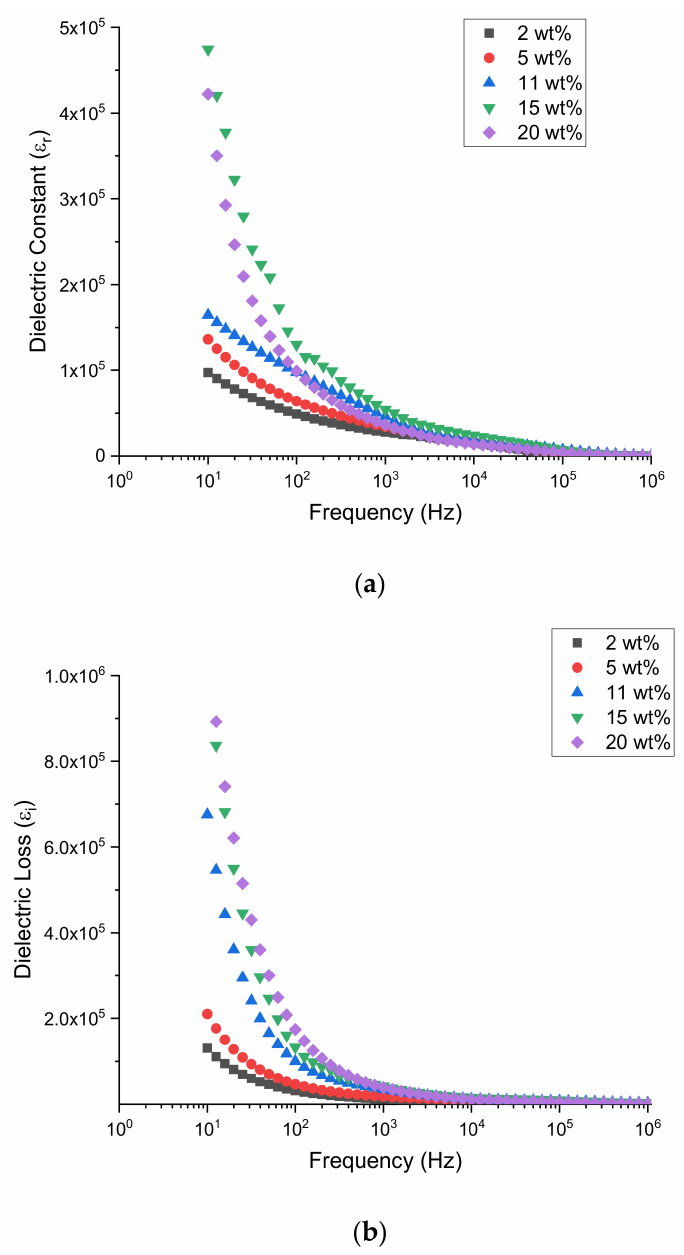
Figure 4. ( a ) Dielectric constant and ( b ) dielectric loss for CH/Na/CuSe polymer matrix with different wt% of CuSe filler measured at room